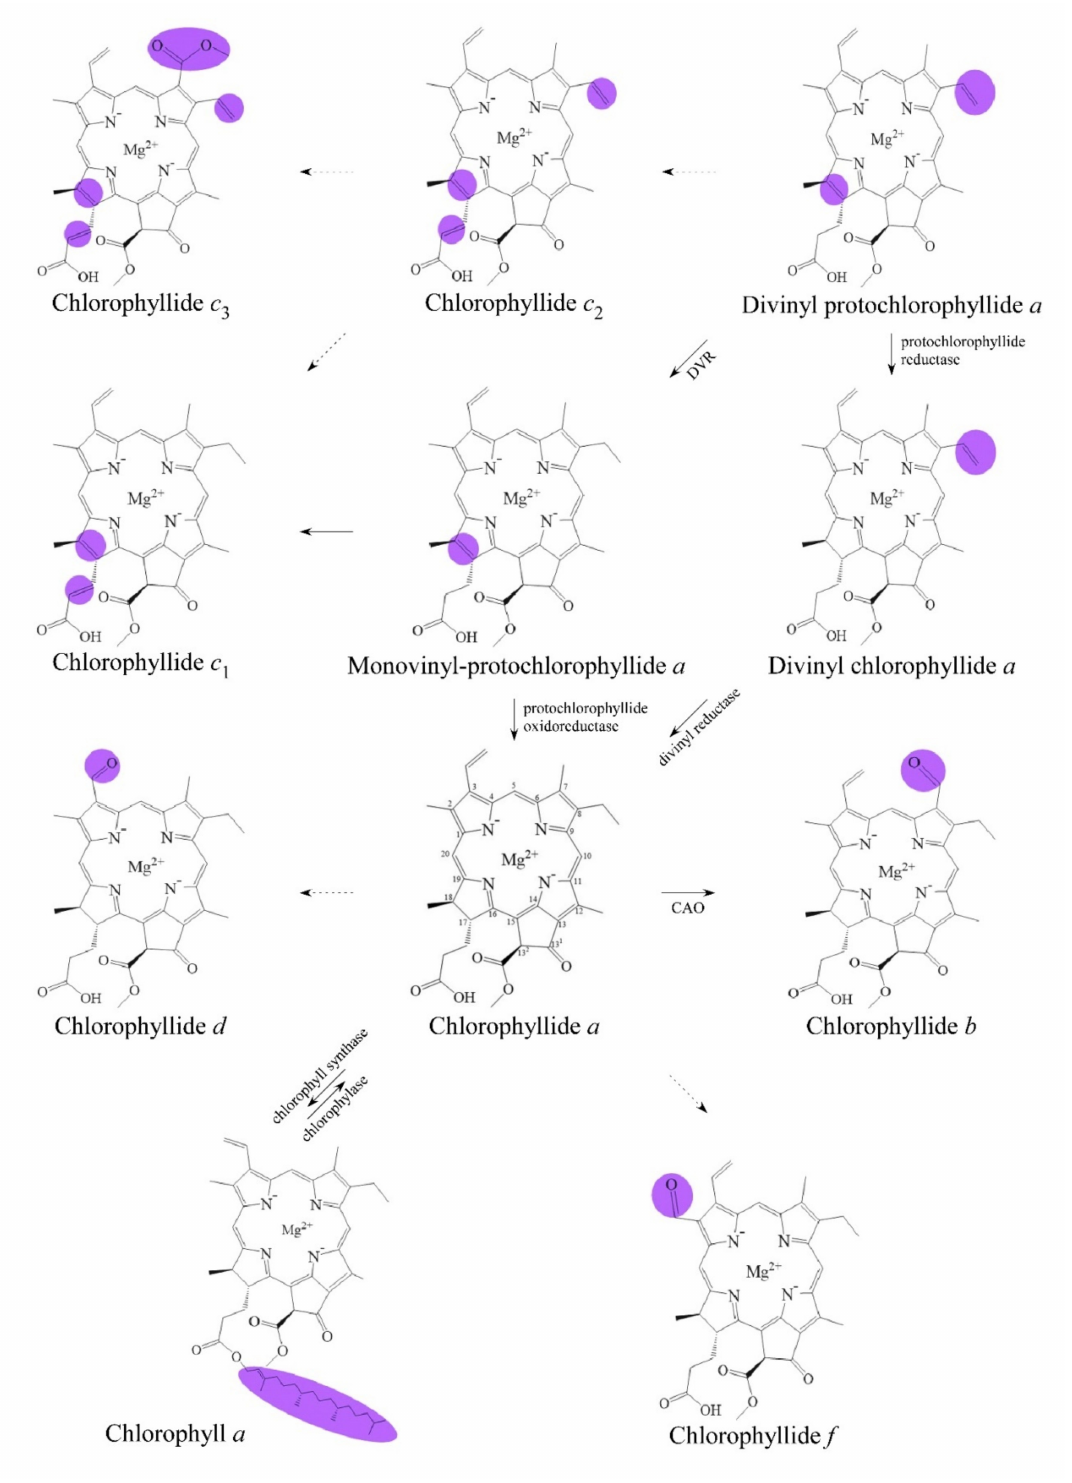
Figure 1. Biosynthetic routes among various chlorophyllides. The structure differences of chlorophyllide derivatives to chlorophyllide a are highlighted with purple coloration. 3,8-divinyl protochlorophyllide a 8-vinyl reductase: DVR; chlorophyllide a oxygenase: